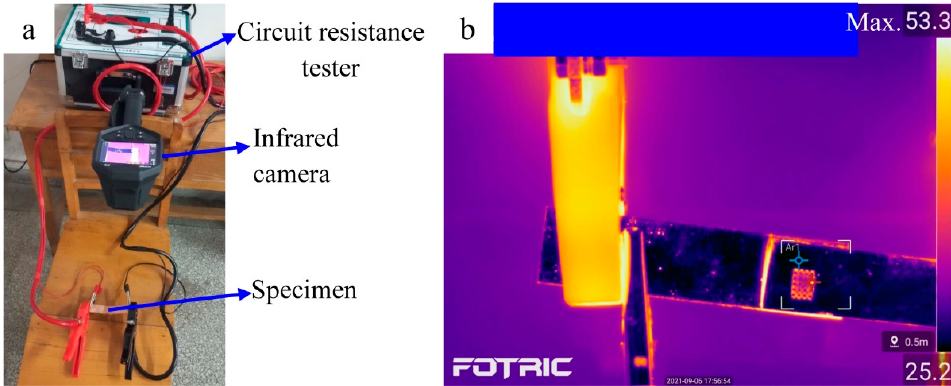
Figure 2. Image of the measuring joint resistance and its corresponding temperature ( a ), and the typical temperature distribution at the weld zone obtained from the infrared thermal image ( b ).